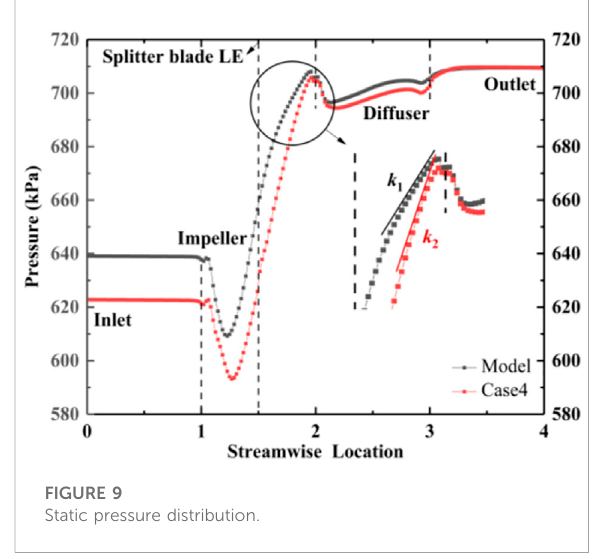
FIGURE 9 Static pressure distribution.